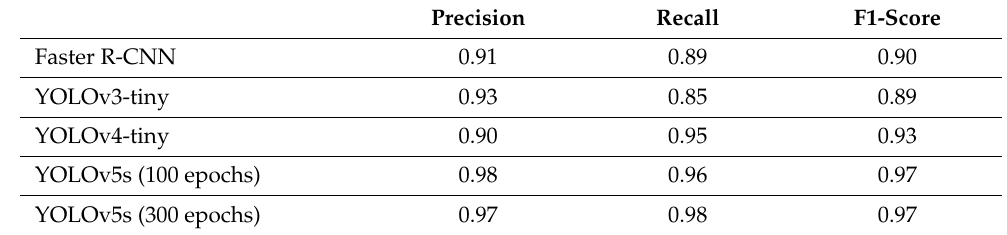
Figure 14. Testing results (top to bottom: plaid, plain, block, horizontal, vertical).